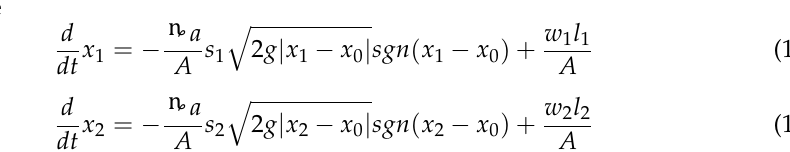
Figure 1. Three-pond hydraulic system.